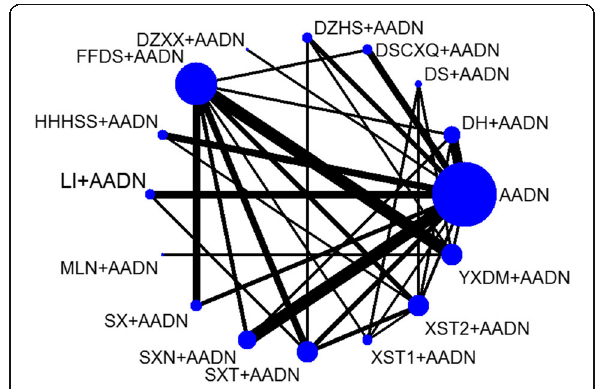
Fig. 2 Network of the included comparisons. Note: Nodes are proportional to the number of patients included in the corresponding treatments, and edges are weighted according to the number of studies included in the respective comparisons